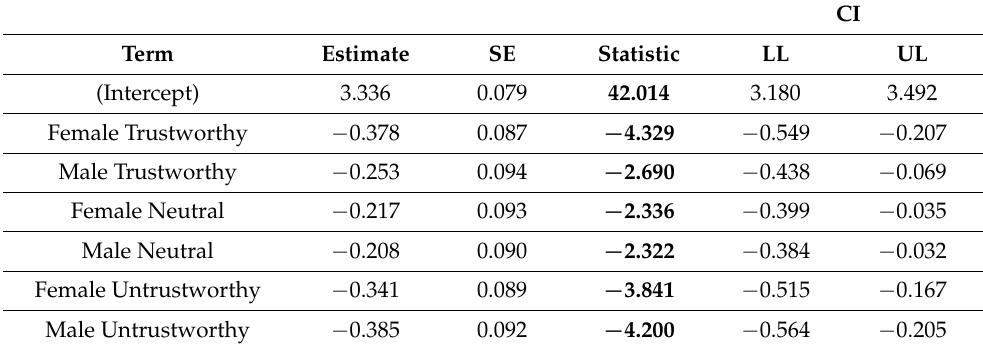
Table 3. Coefficient of glmm on response times. Each coefficient is a contrast between the baseline and the condition. CI = 95%. LL = lower level. UP = upper level. Significant statistics ( t as z criterion) are reported in